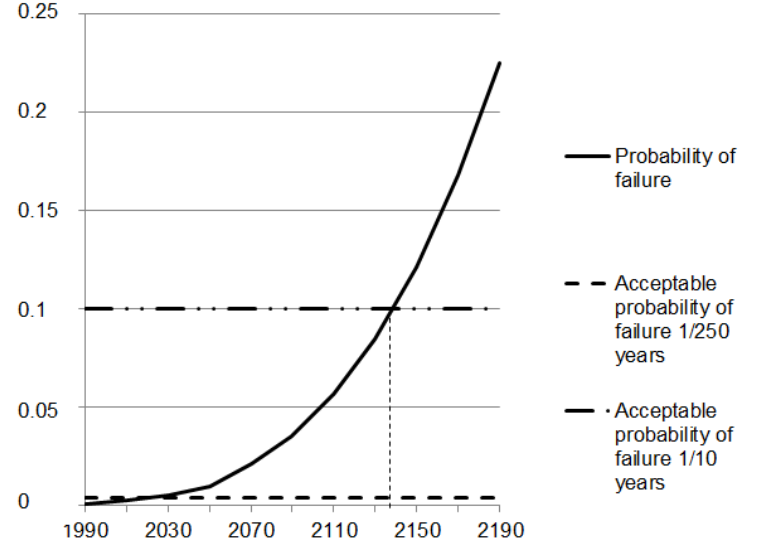
Figure 7. Probability of failure of the drainage system in the tunnel under climate change scenario compared with acceptable levels of